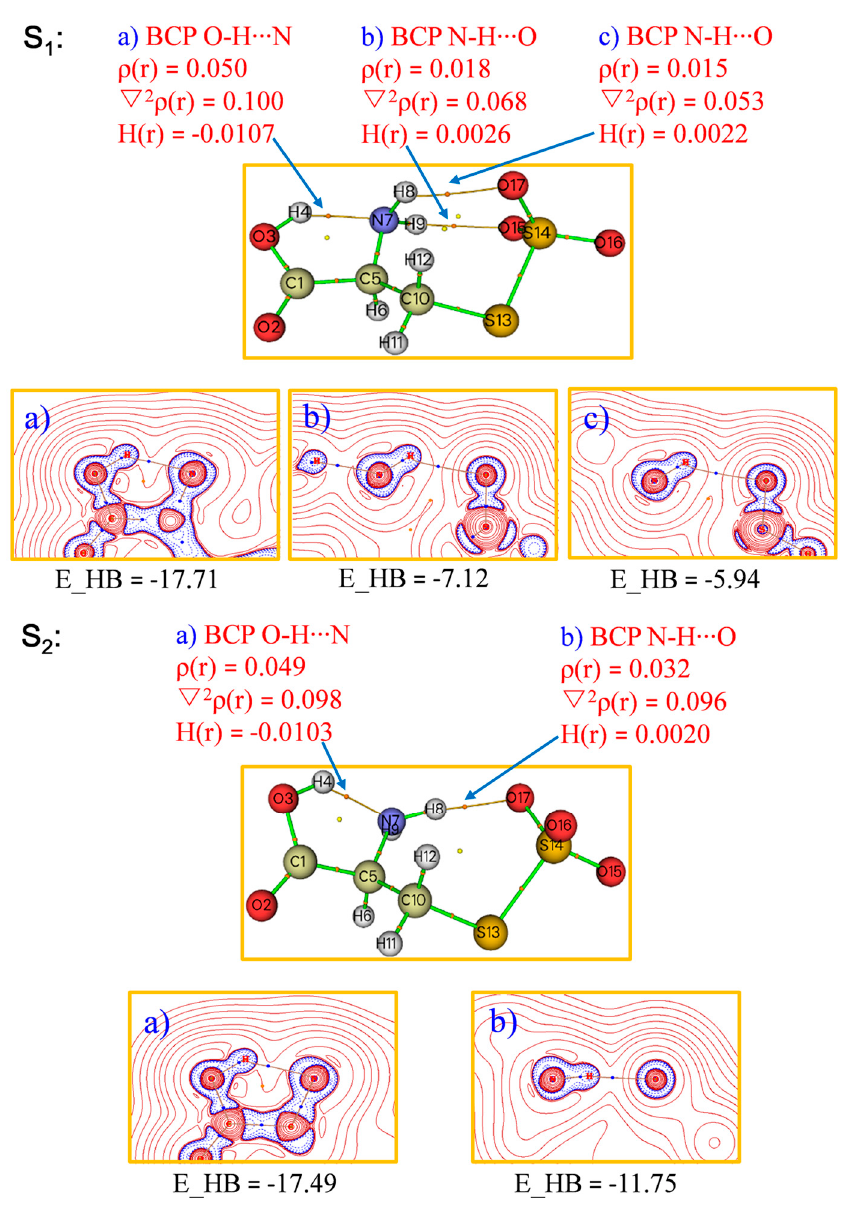
Figure 7. QTAIM analysis for the most stable conformers, S 1 and S 2, of the cysteine perthiosulfonate anion [ cysS-SO 3 ] − .